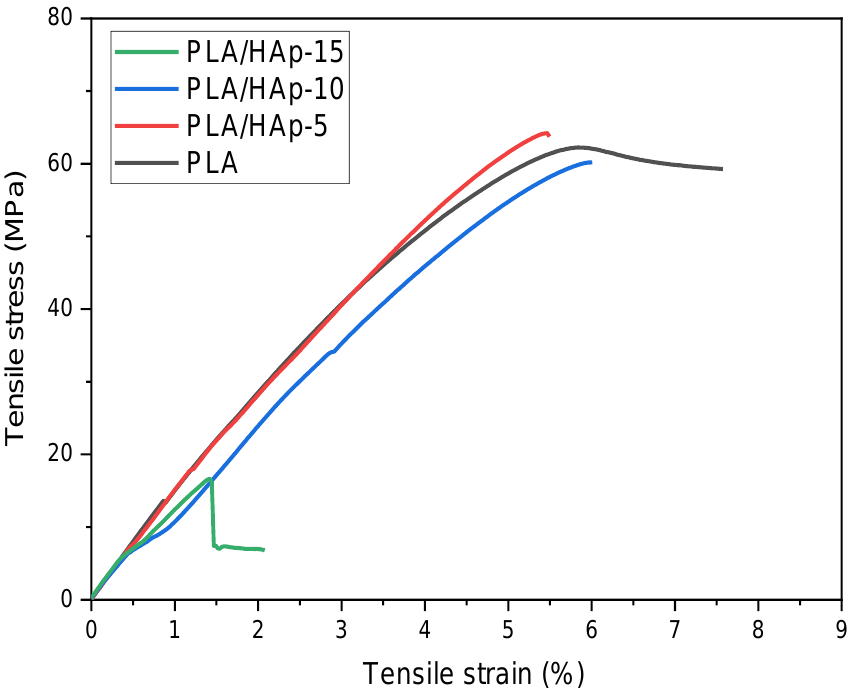
Figure 10. Representative stress – strain curve of the neat PLA and PLA/HAp composites at various filler contents, i.e., 5, 10 and 15 wt%.